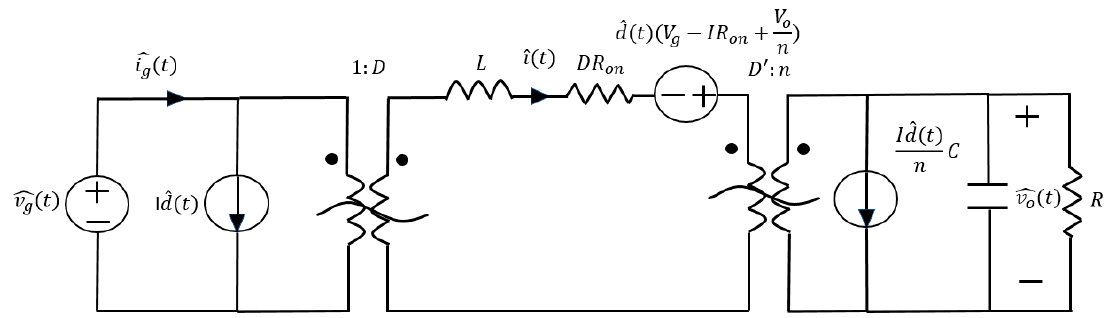
Figure 4. Small-signal ac equivalent circuit of the DMBFC.